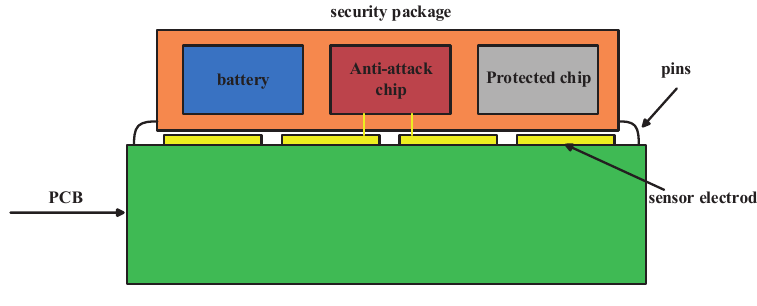
Figure 3. Safe protection